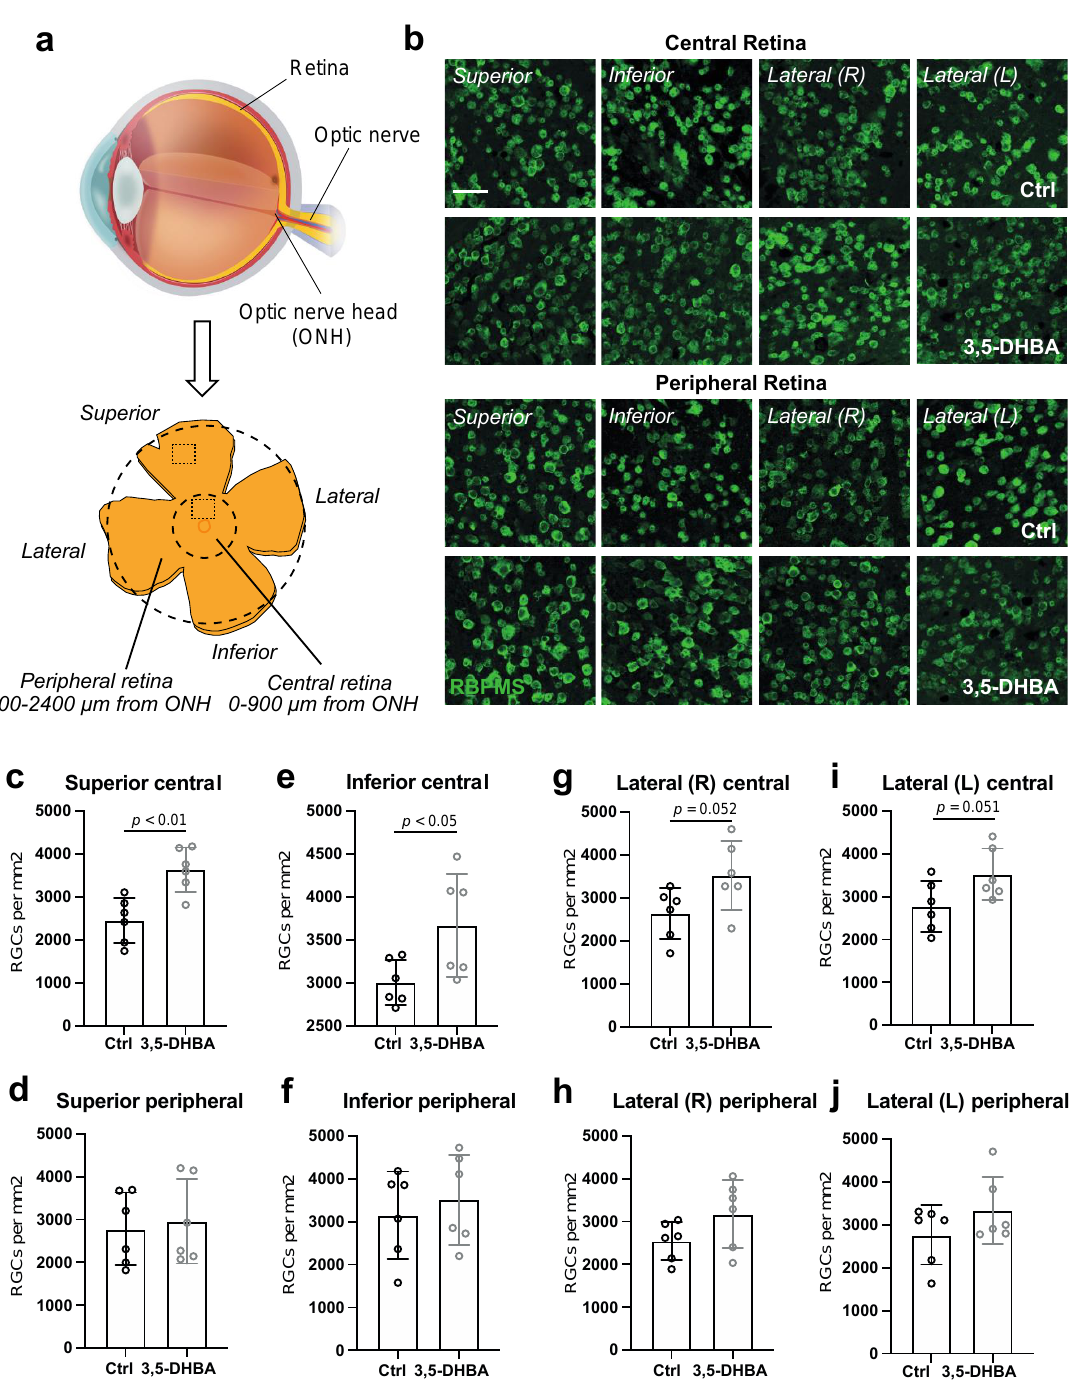
Figure 2. Retinal ganglion cell (RGC) quantity is increased in central parts of the retina in response to 3,5-DHBA treatment. ( a ): Graphical illustration of the cross-sectional eye and a retinal wholemount presenting the areas in which RGC quantification was performed (Modified from Tams et al. [46]). ( b ): Representative microscopy images of RBPMS staining of RGCs in the central and peripheral superior, inferior, and lateral regions. ( c – j ): RGC quantification (RGCs/mm 2 ). Amount of RGCs is elevated in central parts of the retina in response to 3,5-DHBA treatment and remain unchanged in the peripheral subregions. Values are presented as mean ± S.D ( n = 6 regions of interest (ROI), where two ROI come from the same retina, and a total of three retinas from three different mice was used for both the treatment and control). Statistics: Unpaired t -test. Scale bar: 100 μ m. ONH: optic nerve head.